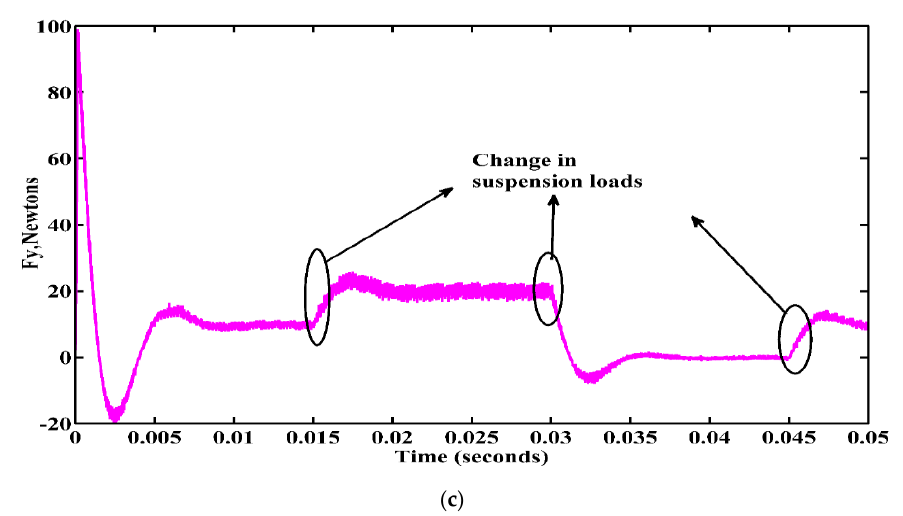
Figure 14. Second Quadrant suspension parameters. ( a ) Rotor dispalcements when suspension loads are applied; ( b ) Suspension force in the X direction when suspension loads are applied; ( c ) Suspension force in the Ydirection when suspension loads are applied.